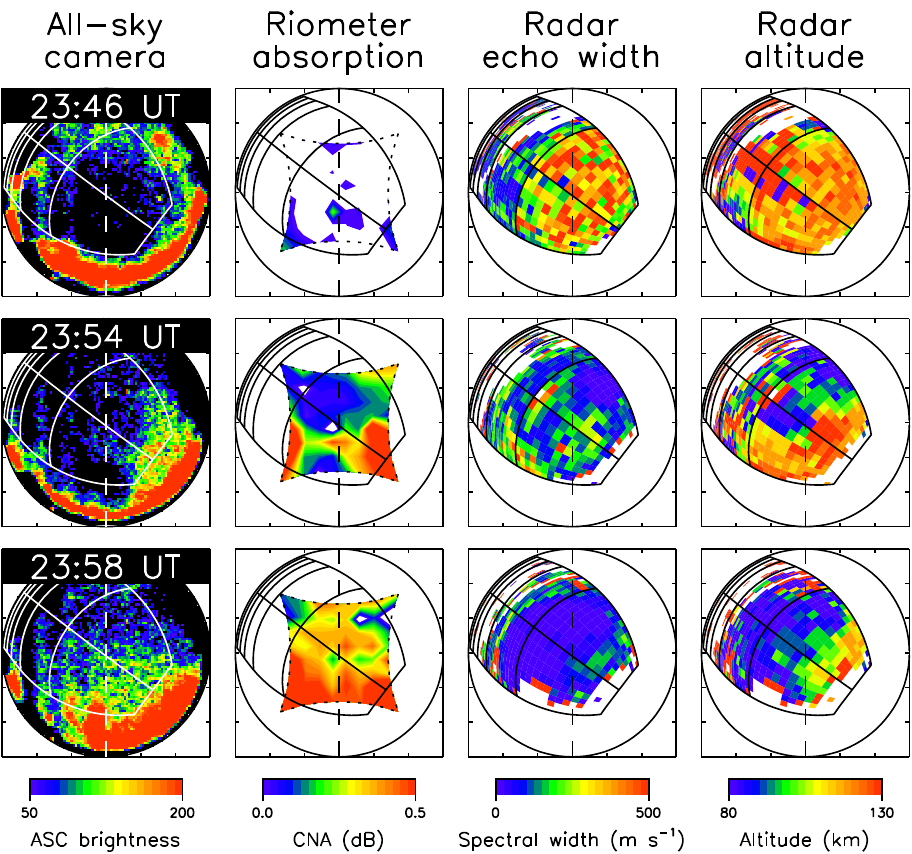
Fig. 1. (Left column) All-sky camera snapshots of the auroral configuration over Tjörnes, Iceland, at three times on the 13 September 1999. Magnetic north and east are to the top and left, respectively. (Second column) Cosmic noise absorption measured by the Tjörnes imaging riometer. (Third column) The spectral width of E region backscatter echoes detected by the Þykkvibær radar. (Right column) The altitude from which the echoes